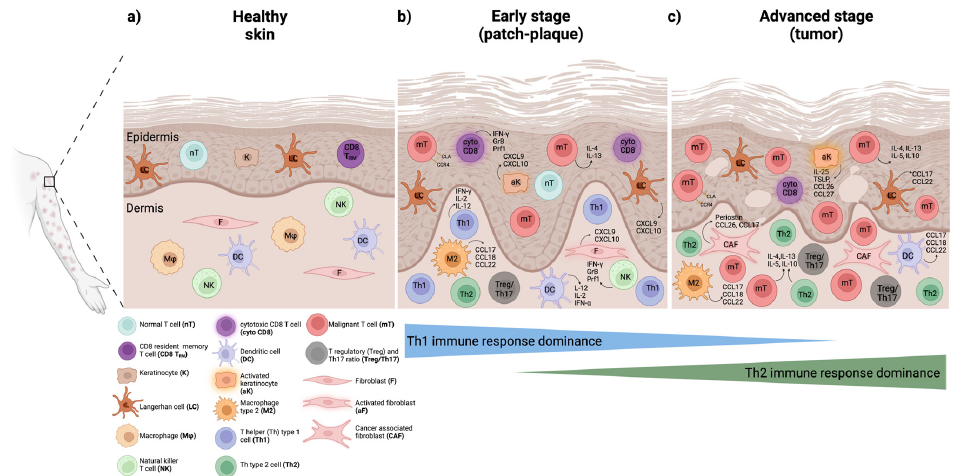
Figure 1. Phenotypic and functional changes in the benign immune cell subsets in the skin mi- croenvironment during MF and SS progression. ( a ) Healthy skin normally containing very few resident immune cell populations in the epidermis and dermis. ( b ) Early stages (patch-plaque stage) charac- terized by few malignant T cells and a predominant anti-tumor Th1 immune response with cyto- toxic CD8 T cells (cyto CD8), Th1 cells, natural killer (NK) cells, and dendritic cells (DCs) playing an important role in restraining malignant T cell proliferation and survival. ( c ) Advanced stages (tumor stage) featured by an increased in fi ltration of benign immune cells and a dominant Th2 im- mune response. Here, Th2 cells, M2 type macrophages (M2), cancer-associated fi broblasts (CAFs), and DCs in the dermis, as well as activated keratinocytes and Langerhans (LCs) in the epidermis, contribute to malignant T cell expansion and disease aggressiveness. Changes in the frequency and abundance of regulatory T cells (Tregs) and Th17 cells shown to accompany disease progression. Production of pro-in fl ammatory, anti-tumor, and tumor-promoting e ff ector molecules demon- strated for each cell type as previously reviewed elsewhere [23,37,55]. The fi gure was generated using BioRender software. 3. Inter-Patient and Intra-Tumor Heterogeneity in MF and SS 3.1. Immunophenotypic Heterogeneity MF and SS exhibit substantial heterogeneity as observed both in the immunopheno- type and transcriptional expression pro fi le of the malignant T-cell population between the di ff erent disease compartments, over time and across patients [50,56,57]. Roelens and col- leagues showed that the phenotype of blood circulating Sézary cells (SCs) largely varied in the expression levels of naïve and central memory markers, while one patient also pre- sented a shift towards a phenotype of stem-cell memory (Tscm), during a six-month fol- low-up [56]. Skin versus blood-derived SCs were shown to markedly di ff er in their matu- ration status, with skin-derived SCs presenting a more di ff erentiated phenotype than the clones in blood, based on the progressive T-cell di ff erentiation model [58]. Additionally, di ff erences in the cytokine and chemokine-receptor expression pro fi le were found in the two anatomically distinct malignant T-cell subsets, a phenomenon previously shown to a ff ect the local e ffi cacy of applied treatment [59]. Consequently, in-depth characterization of the relationship between skin and blood compartments may encompass potential im- plications in the discovery of new therapeutic targets in CTCL. Of speci fi c interest, Immunophenotypic switch (IS), a rarely reported phenomenon in CTCL, has been previously identi fi ed in up to twenty- fi ve CTCL patients [60]. IS is de- fi ned as a change in the immunophenotype of tumor cells while maintaining their genetic